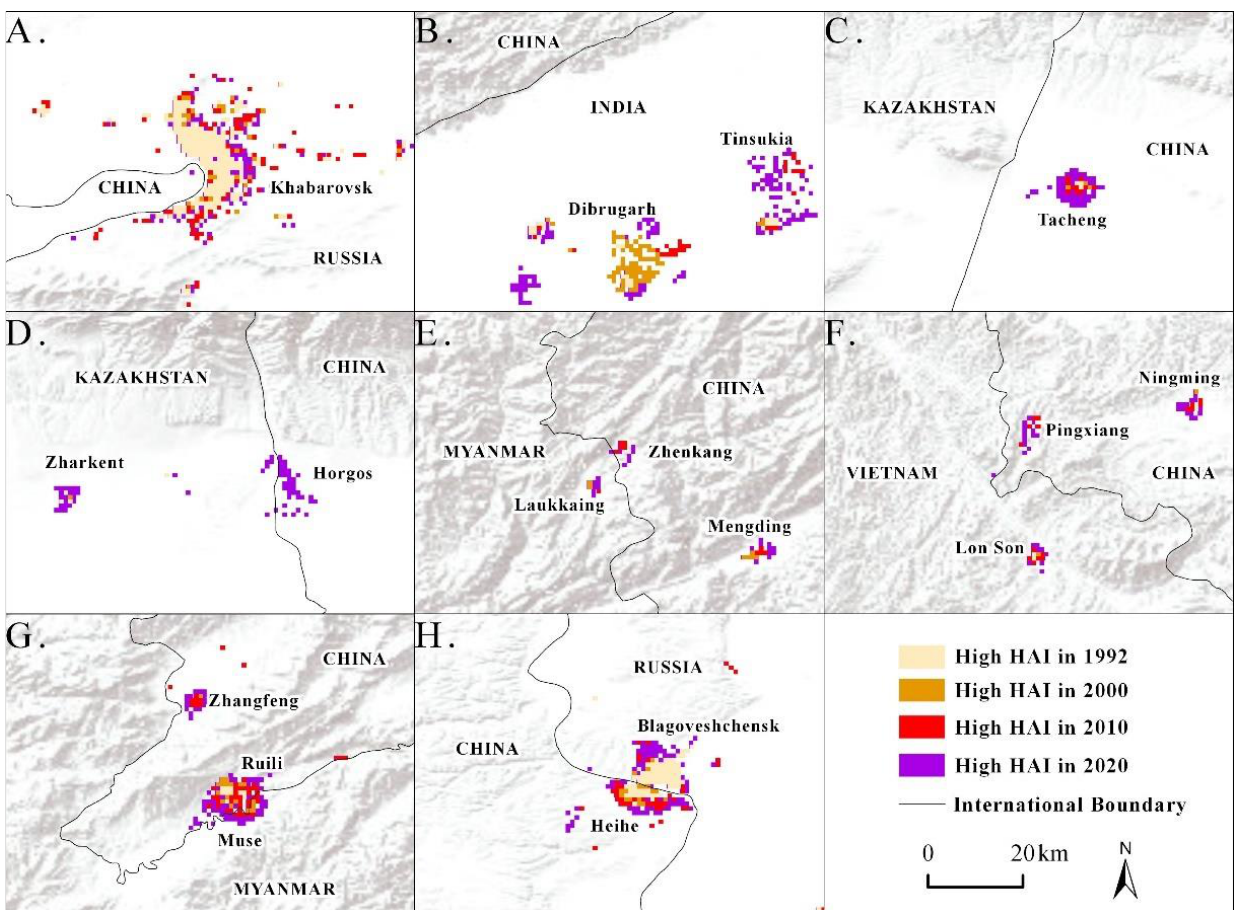
Figure 7. High HAI areas change form. Unilateral expansion areas ( A – C ); Bilateral expansion areas ( D – F ); Cross-border integration areas ( G , H ).